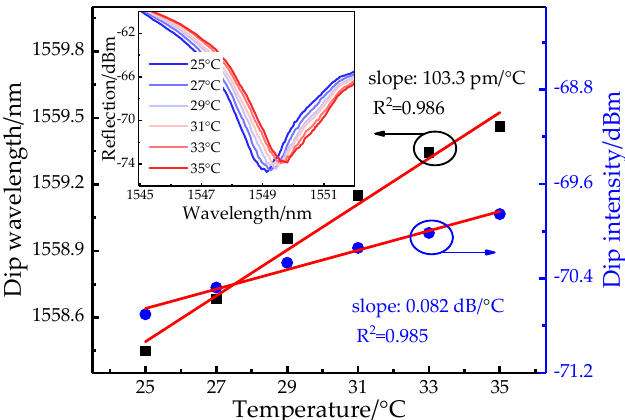
Figure 10. Wavelength and intensity relationships in DP structure with varied temperature.